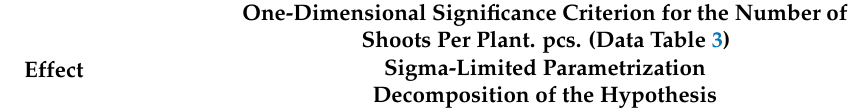
Table A2. Results of multivariate analysis of variance values of H. cretaceus shoot multiplication coefficient in vitro .